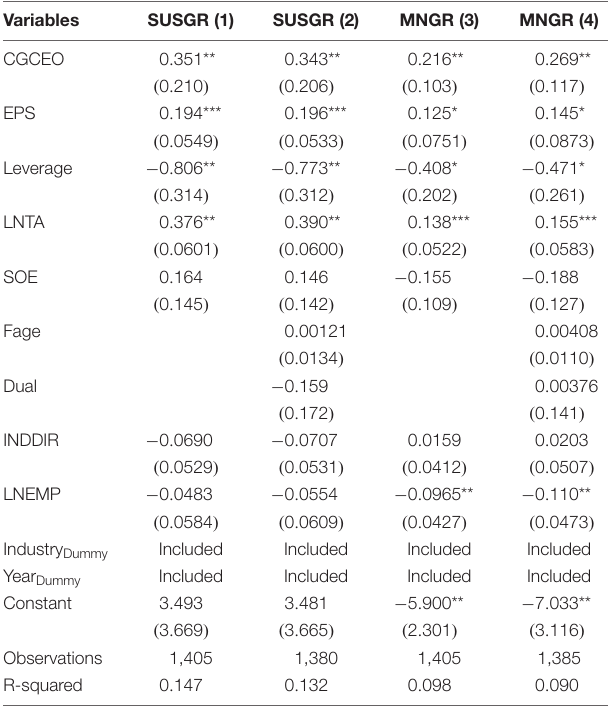
TABLE 3 | 2SLS regression for cognitive CEO and sustainability. TABLE 4 | 2SLS regression for moderator agency cost between cognitive CEO and sustainability.